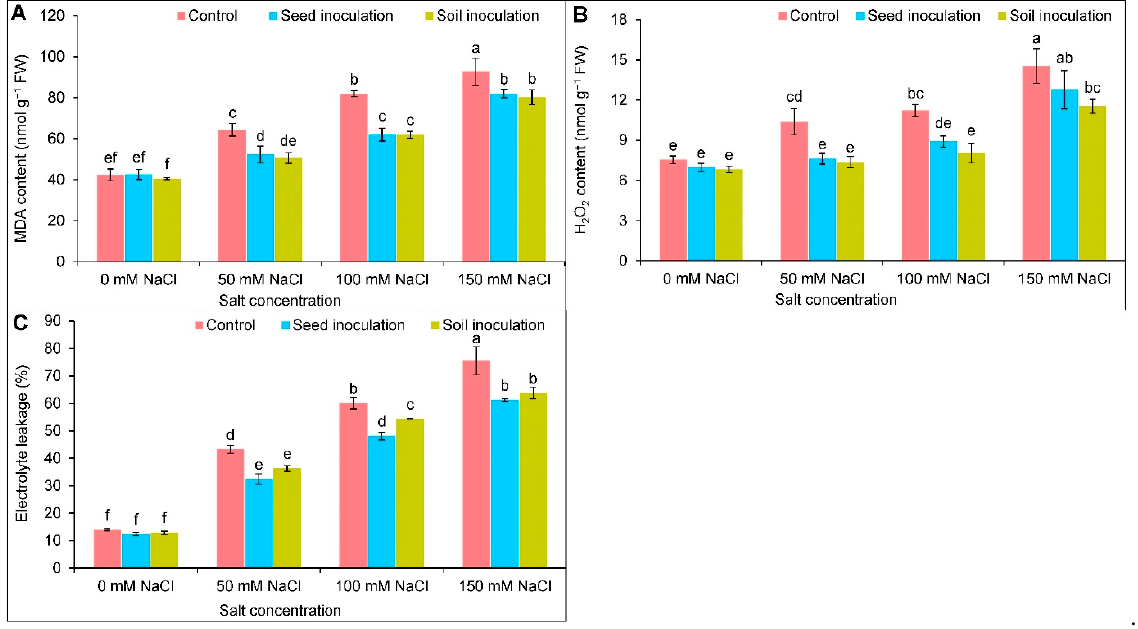
Figure 4. Effect of Bacillus subtilis in response to different concentrations of salt stress on the contents of MDA ( A ), H 2 O 2 ( B ), and electrolyte leakage ( C ) of soybean ( Glycine max cv. BARI Soybean-5). Values in a column are mean ± SD. Different letters on each bar indicate significant differences among the treatment after applying a Tukey’s HSD test at p ≤ 0.05.